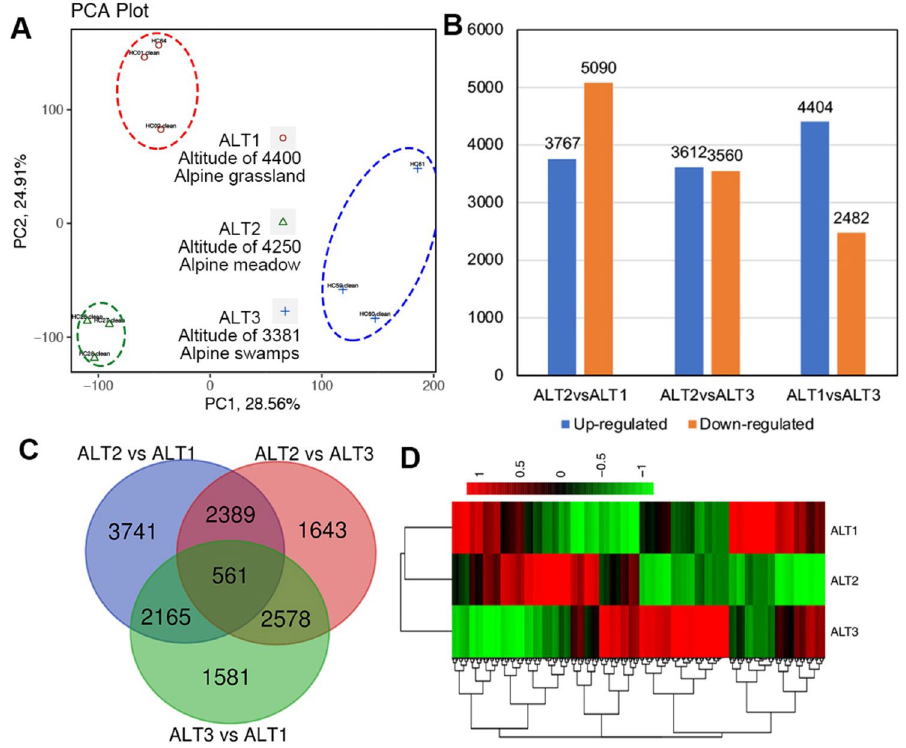
Figure 3. Overall differentially expressed genes (DEGs) of Carex parvula from different altitudes and environments. ( A ) Principal component analysis (PCA) of differentially expressed genes (log2 (relative expression level) ≥ 1 and ≤ − 1, DEGs) in 3 groups. ( B ) The histogram of the statistical results for the DEGs in 3 groups. The orange for down-expressed genes and the blue for up-expressed genes. ( C ) Venn diagram of the overlap between the DEGs between ALT2 vs ALT1, ALT2 vs ALT3 and ALT3 vs ALT1. D, The clustering analysis results of the relative expression levels of the different groups.